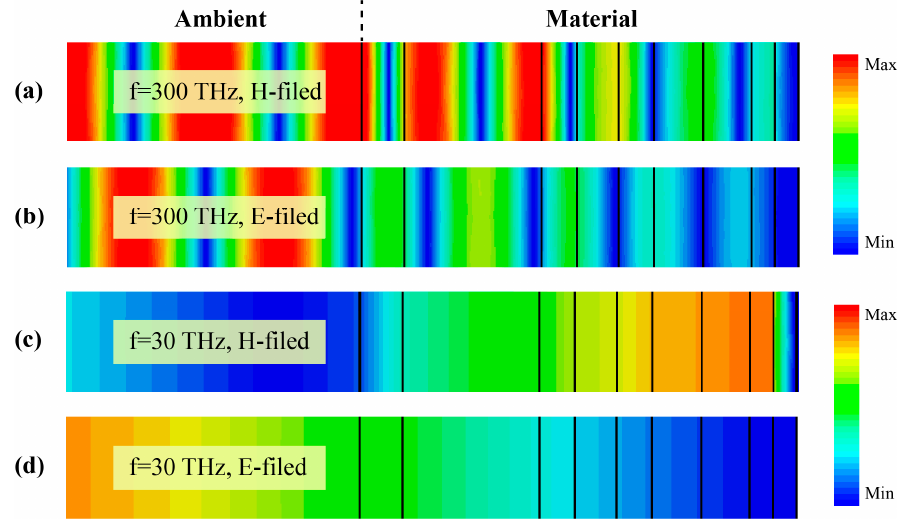
Figure 4. The electric field and magnetic distribution in the simulated material and the ambient. The left side of the dotted line is the domain of the ambient and the right side is the domain of coating. ( a , c ) Distribution of the magnetic field at frequency of 300 THz and 30 THz, respectively; ( b , d ) distribution of the electric field at frequency of 300 THz and 30 THz,